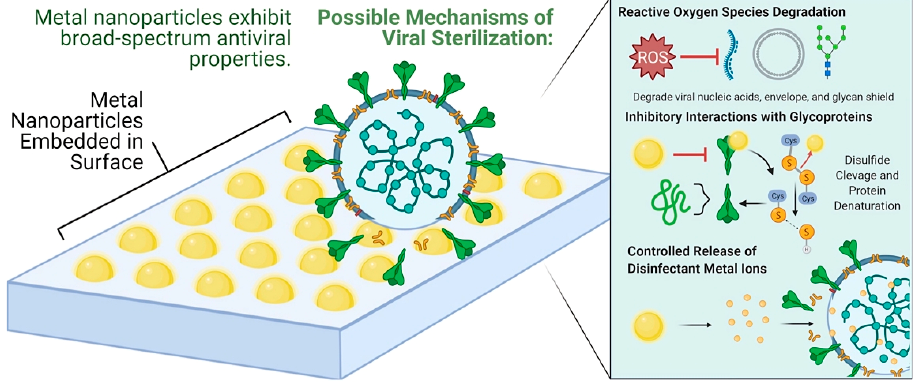
Figure 5. Possible antiviral mechanism of metal nanoparticles (reprinted with permission from Lin et al. [43]).